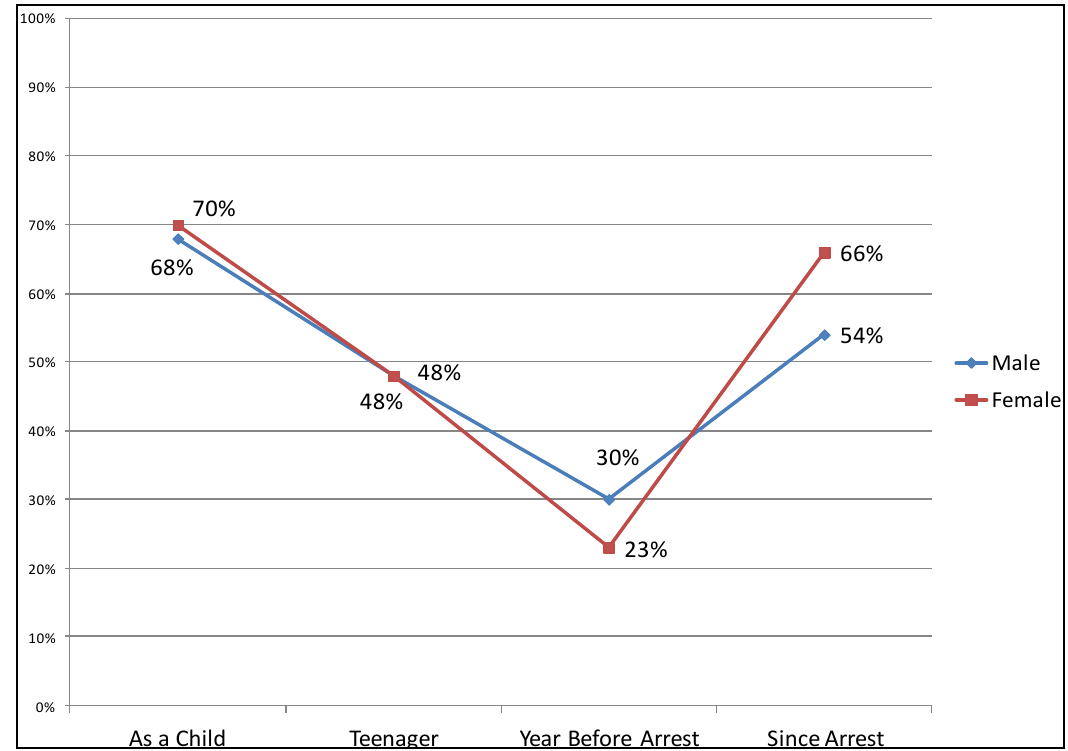
Figure 2. Religious/Spiritual Involvement (once a month or more) over Time for Females and Males (N =